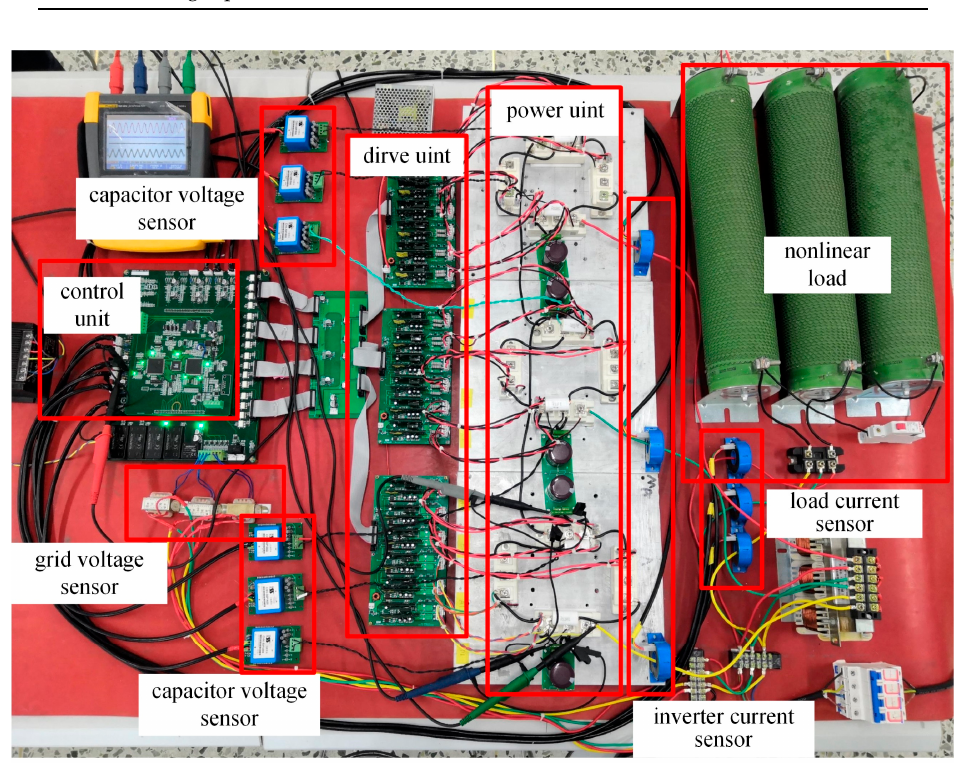
Figure 15 . Experiment system platform. Figure 15. Experiment system